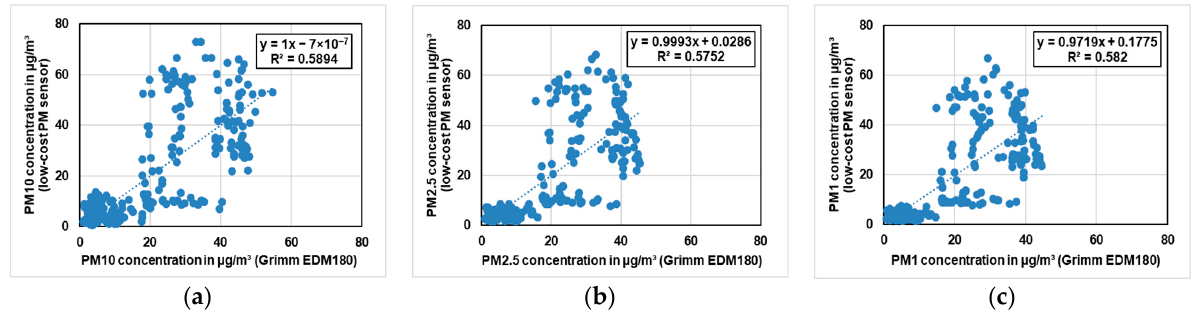
Figure 18. PM10, ( b ) PM2.5 and ( c ) PM1 comparison of low-cost PM sensor with Grimm EDM180 during the whole campaign at Marienplatz for the period with relative humidity above 70%.